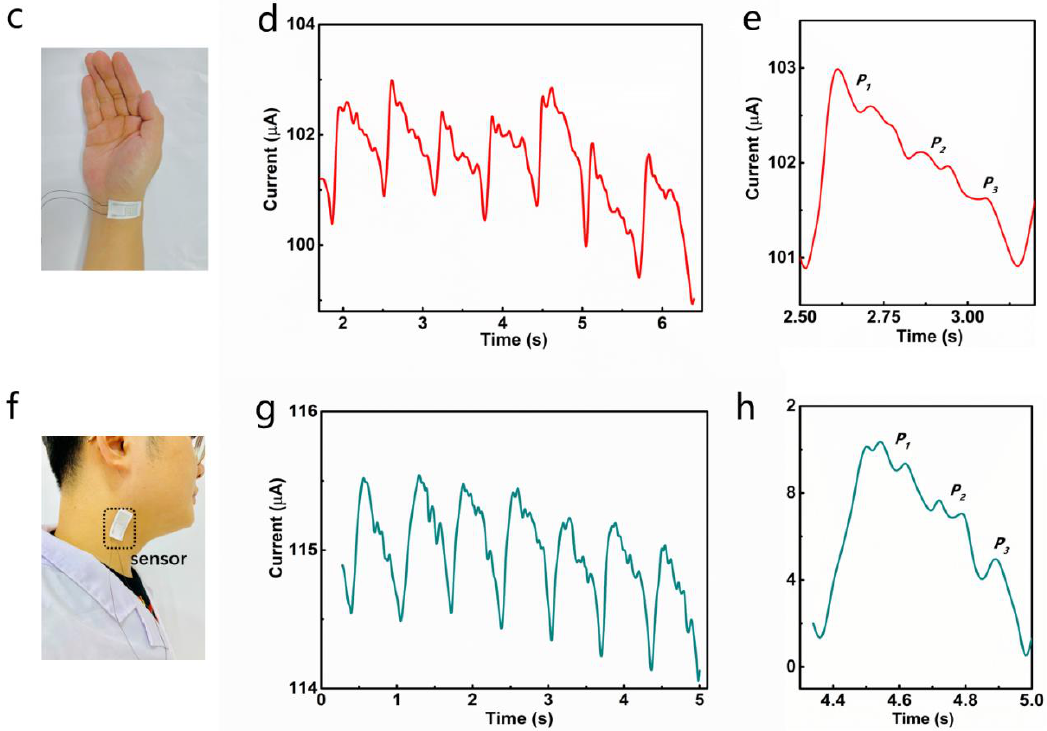
Figure 5. Real-time detection of di ff erent electrical signals using the NCB-coated PDMS pressure sensor: ( a ) The response of relative current changes caused by rapid whirling of the wrist. ( b ) The current signal for detecting di ff erent strengths of gas generated from the mouth. ( c ) Photograph of a sensor mounted on the wrist for pulse detection. ( d , e ) A wrist pulse waveform and a single pulse waveform recorded by the NCB sensor. ( f ) An optical image of the NCB-coated PDMS sensor attached to the neck for arterial pulse waves’ detection. ( g ) Neck pulse waveform of the test sensor and ( h ) a single pulse waveform.